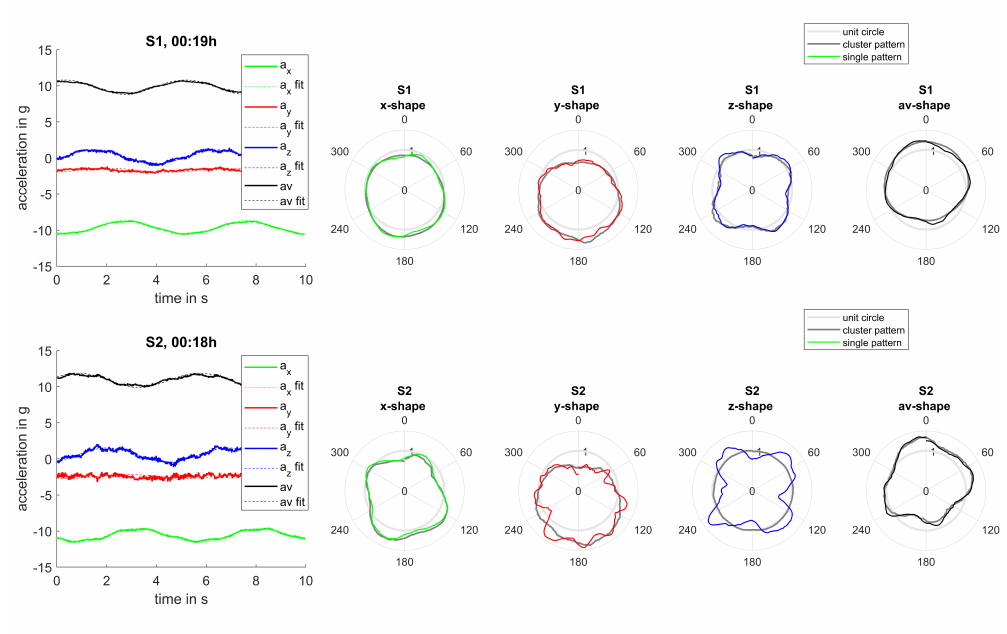
Figure 16. Joint analysis, event 1: Comparison of bending patterns for sensors S 1 and S